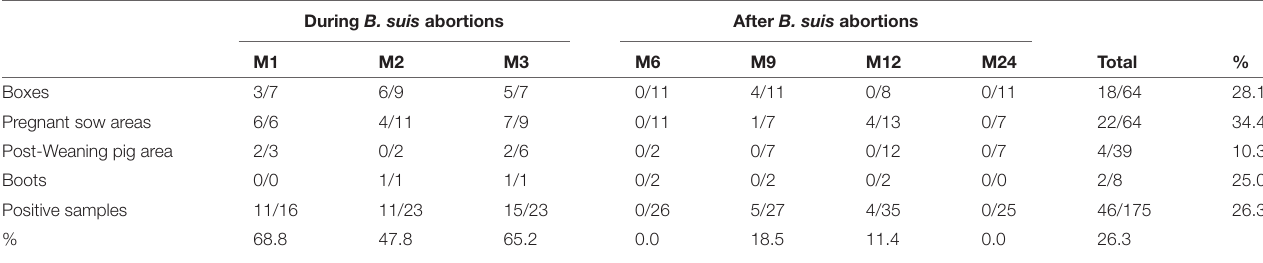
TABLE 1 | Results for the polymerase chain reaction (PCR) evaluation of environmental samples at different moments in time (months) and in different locations throughout the study. During B. suis